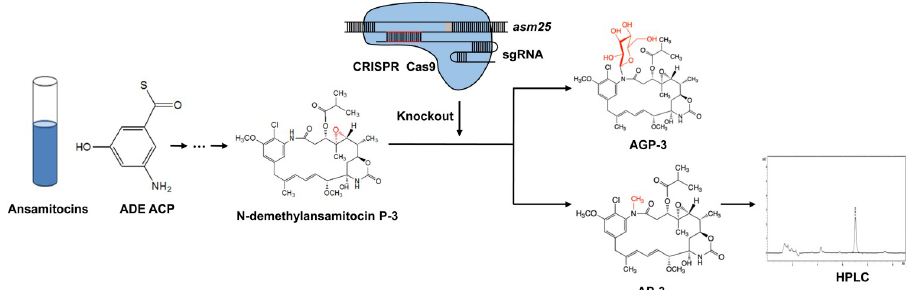
Fig 1. Schematic of the biosynthesis pathway of AP-3 and a brief workflow.